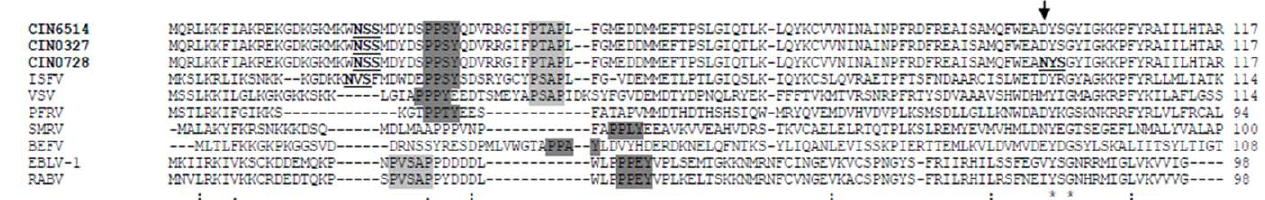
Figure 5. Profile alignment of M protein (res: 1 – 117) of representative CHPV isolates (indicated in bold) with other representative rhabdoviruses. The conserved PPxY and Px[TS]AP motifs are highlighted in grey. Putative glycosylation sites are underlined. The mutations within the CHPV isolates are indicated by downward arrows.